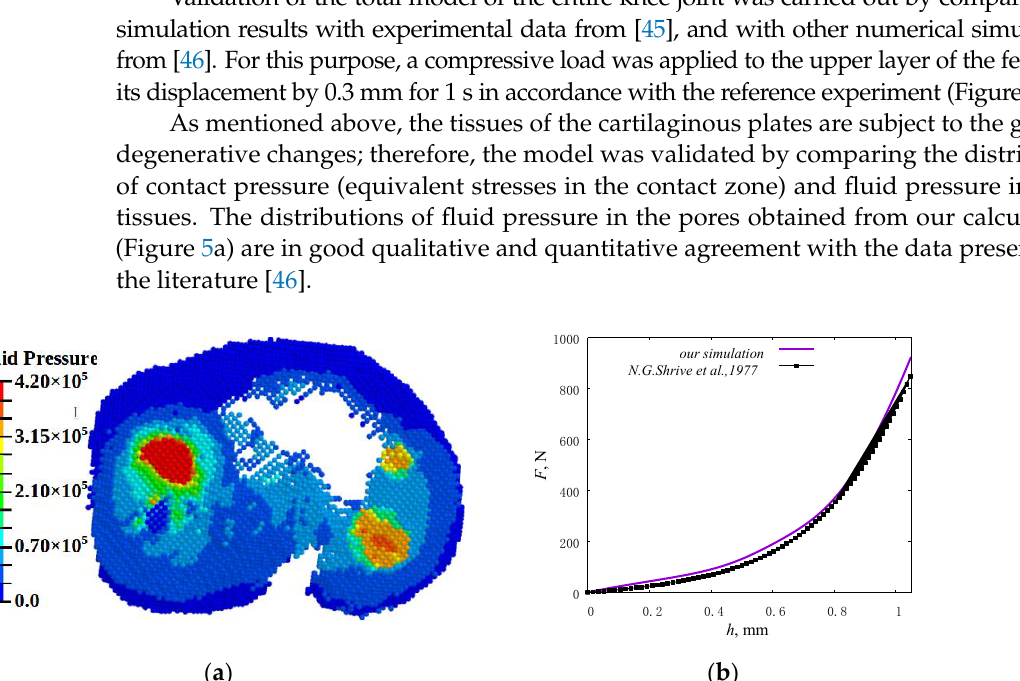
Figure 5. Results of the model validation: ( a ) distributions of fluid pressure (Pa) in the tibia carti- lage pores (our simulation); ( b ) plots for applied force versus displacement.